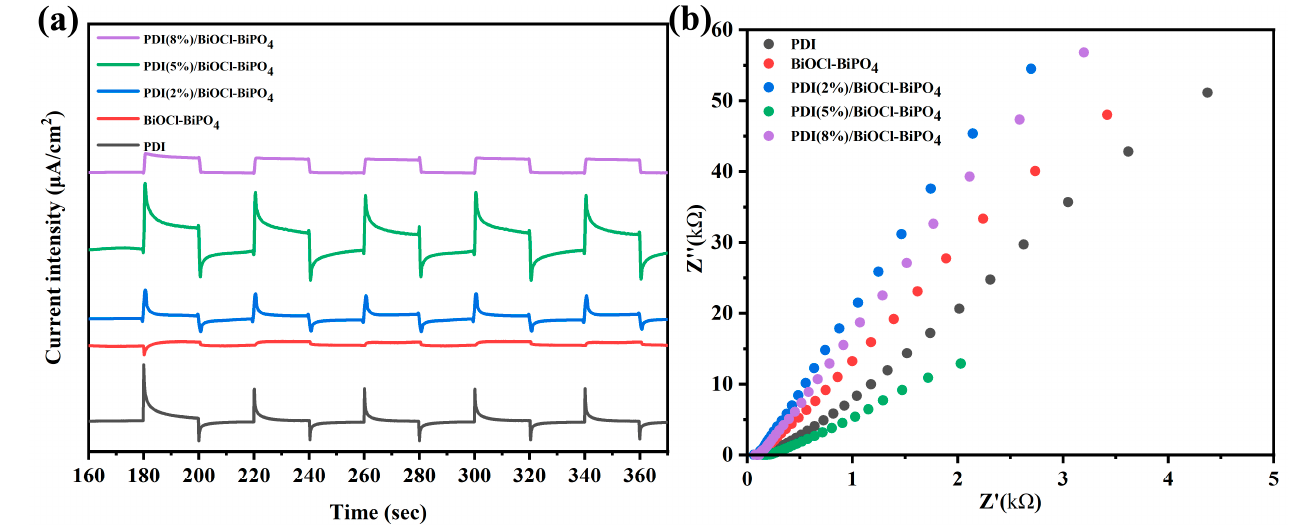
Figure 8. ( a ) The transient photocurrent response of PDI, BiOCl-BiPO 4 , PDI(2%)/BiOCl-BiPO 4 , PDI(5%)/BiOCl-BiPO 4 and PDI(8%)/BiOCl-BiPO 4 samples simulated solar light irradiation. ( b ) The electrochemical impedance spectroscopy (EIS) of PDI, BiOCl-BiPO 4 , PDI(2%)/BiOCl-BiPO 4 , PDI(5%)/BiOCl-BiPO 4 and PDI(8%)/BiOCl-BiPO 4 samples.